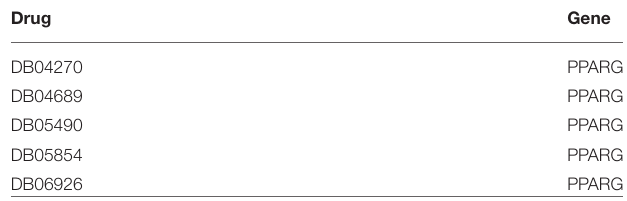
TABLE 1 | PPARG drug target list.